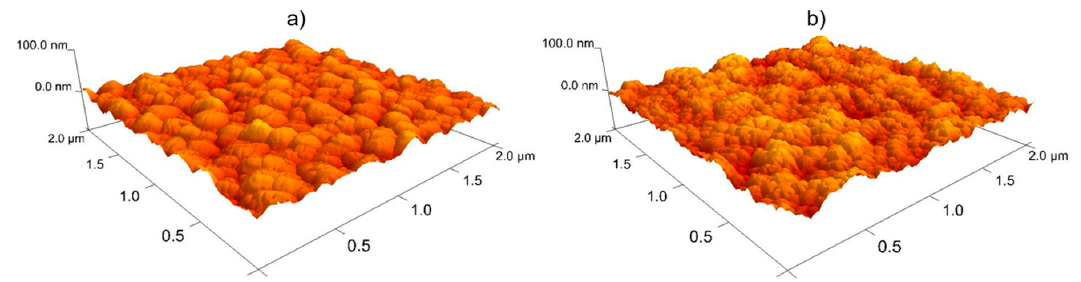
Figure 2. Three-dimensional atomic force micrographs (AFM) showing surface morphology of ( a ) Ag deposited on SLG / Cr and ( b ) ZnO deposited on SLG / Cr / Ag.